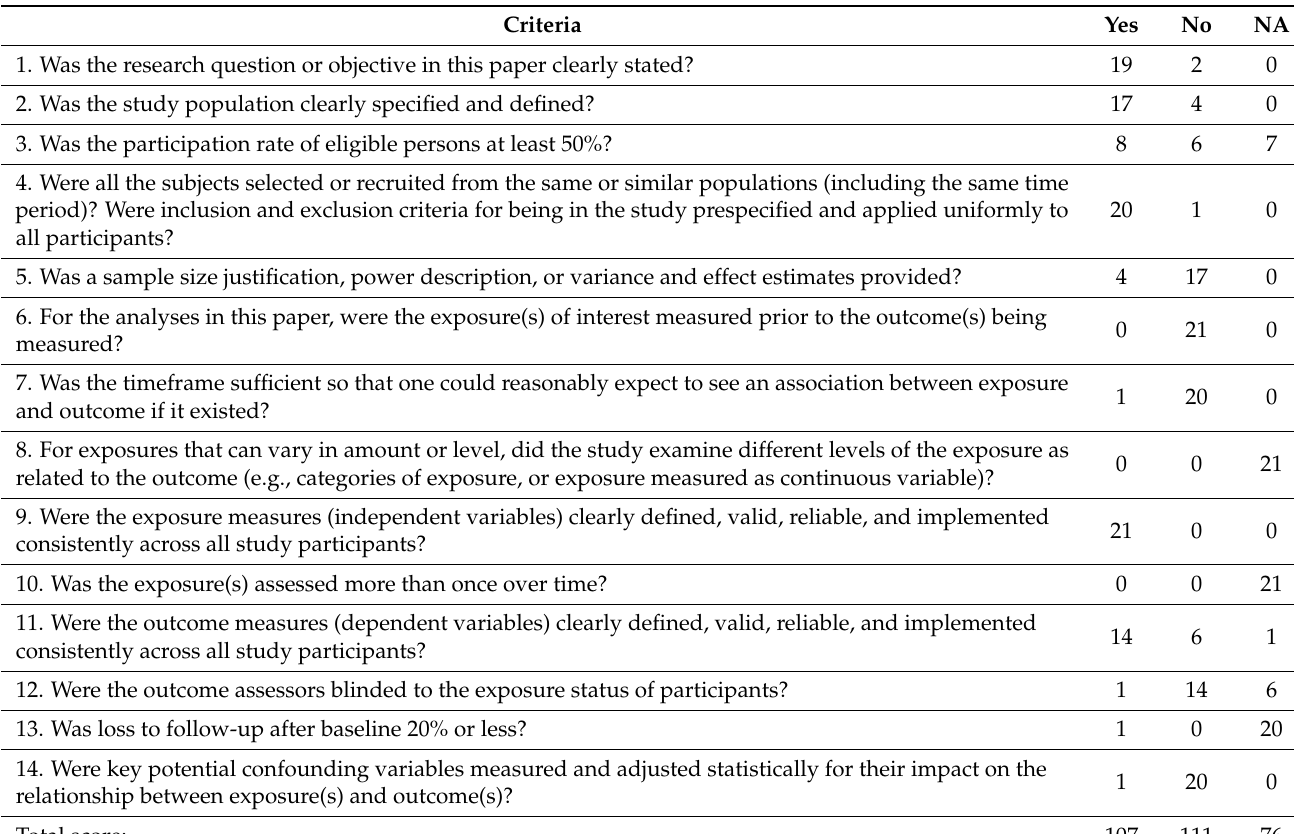
Table 3. Assessment of risk of bias (N =